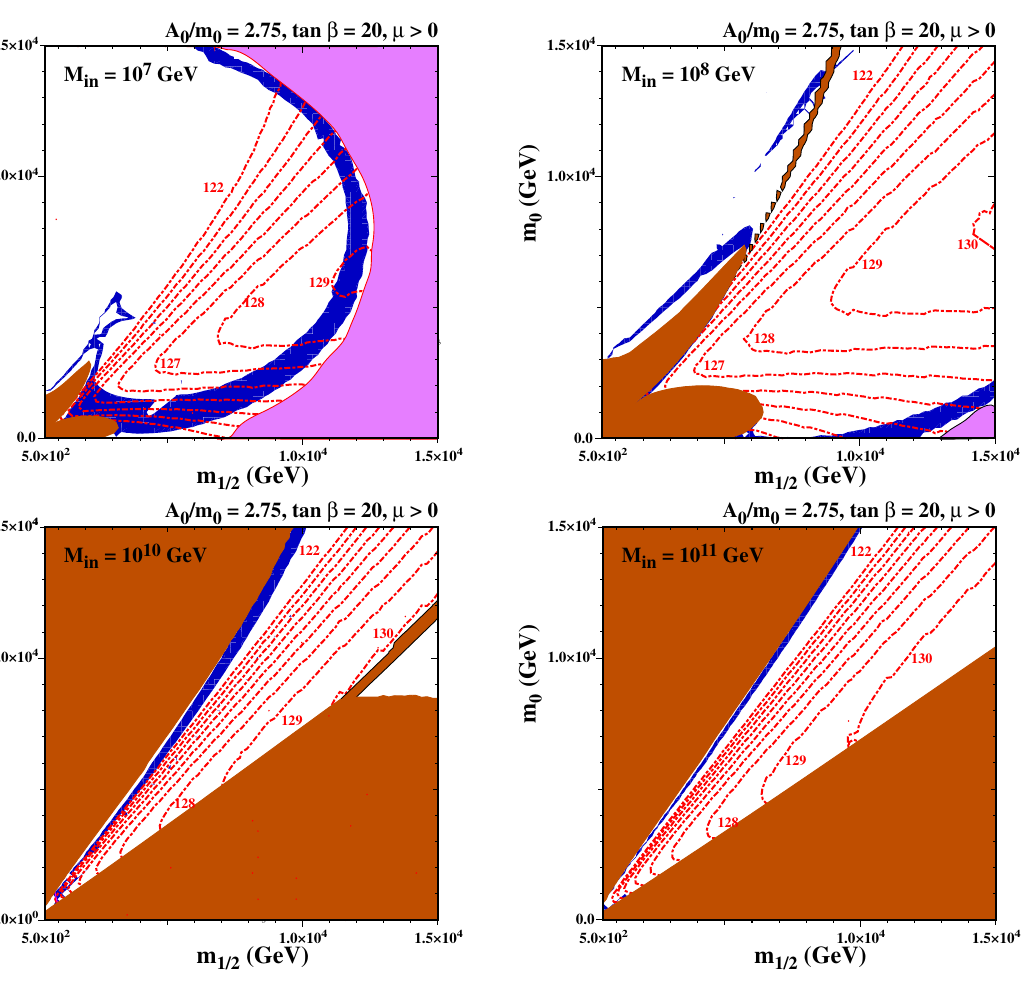
Fig. 8 The ( m 1 / 2 , m 0 ) planes sub-GUT models with tan β = 20, A 0 = 2 . 75 m 0 and M in = 10 7 GeV (upper left), M in = 10 8 GeV (upper right), M in = 10 10 GeV (lower left), and M in = 10 11 GeV